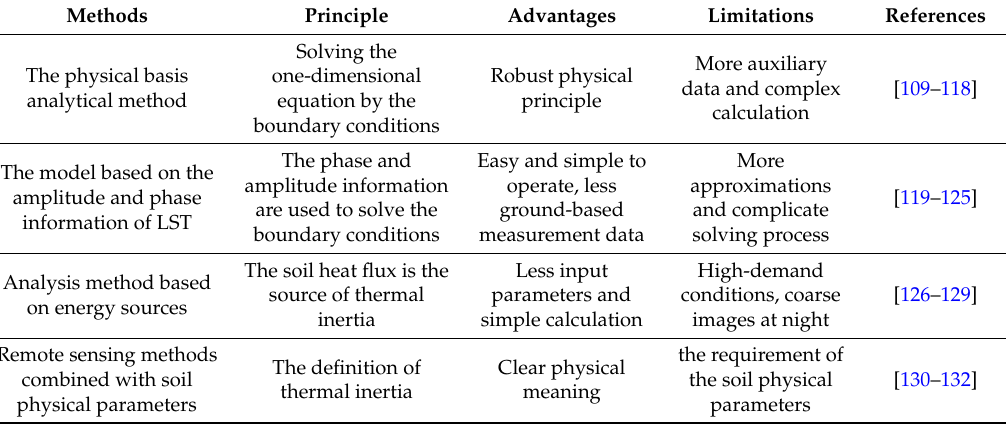
Table 3. Comparisons of the common thermal inertia